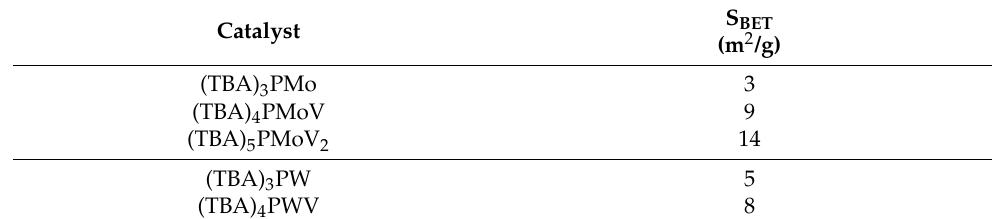
Figure 5. N 2 -adsorption isotherm of pure and V-substituted Mo ( a ) and W ( b ) Keggin-type polyoxometalates. Table 2. Textural properties of the pure and substituted Mo and W catalysts.